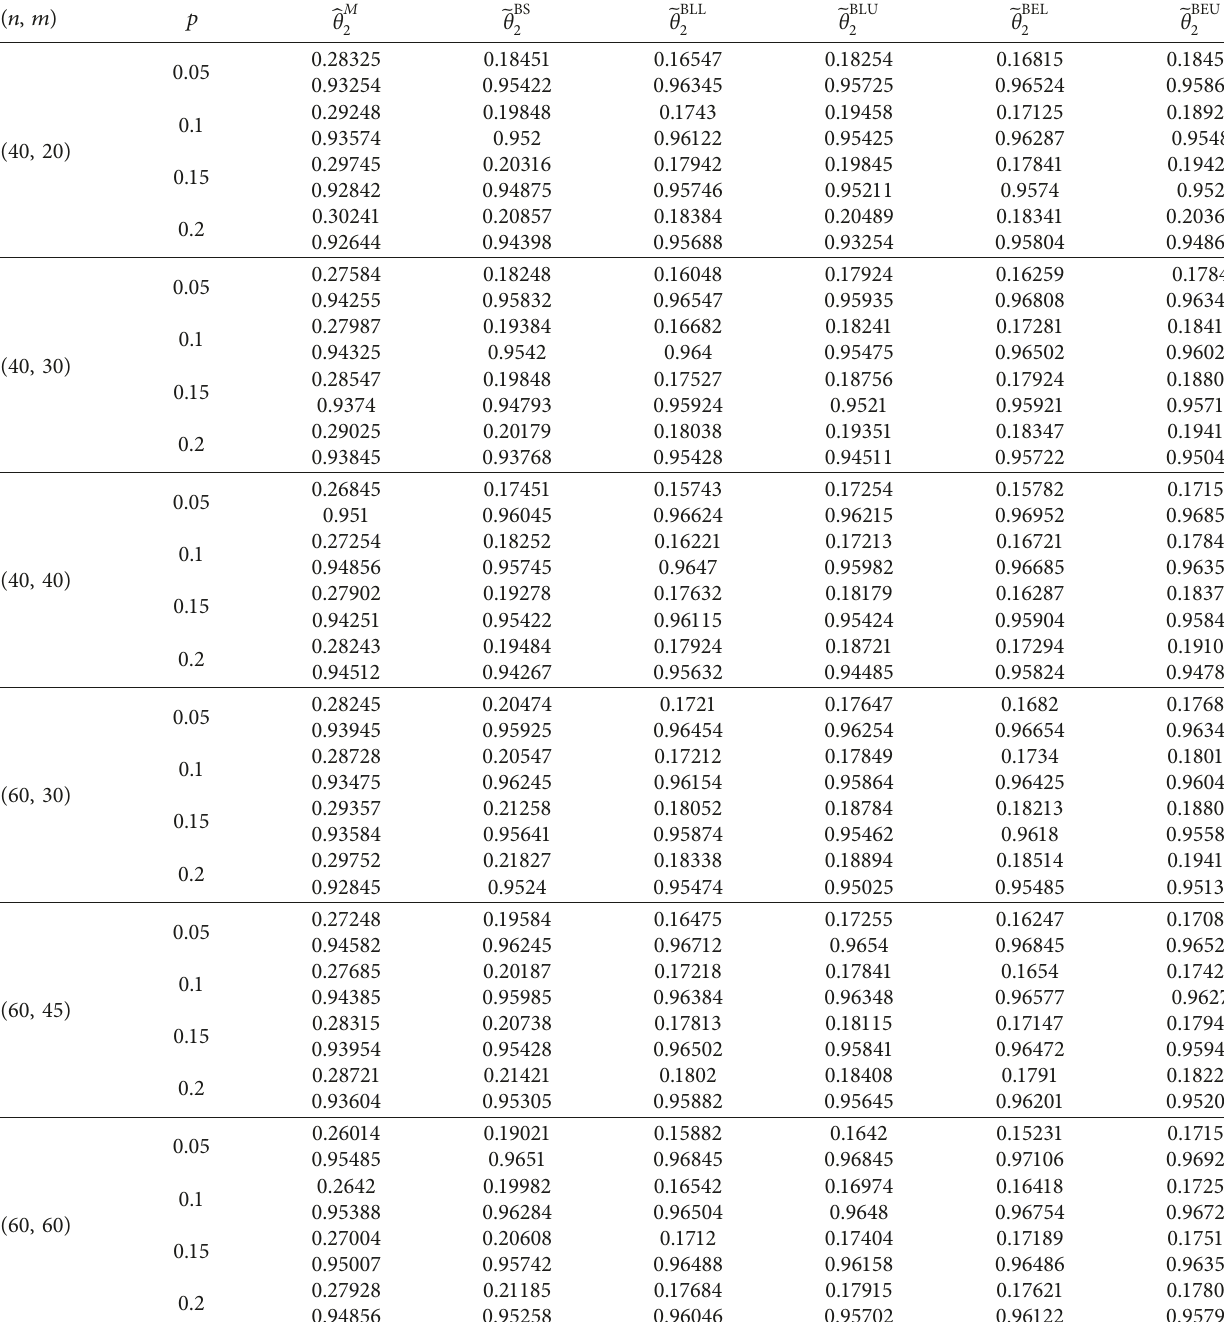
with their coverage probability of different m for n and p 1